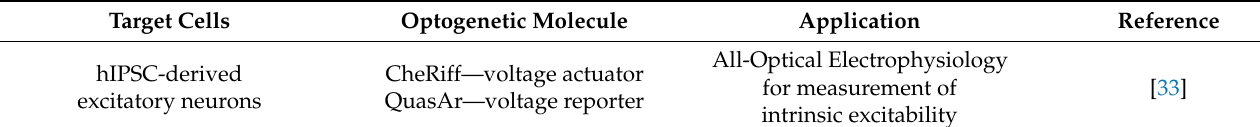
Table 2. Optogenetic reporter cells relevant for cell-based biosensing